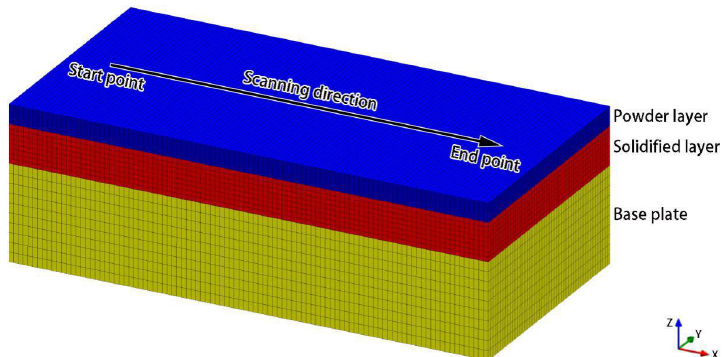
Figure 4. Adopted geometry and mesh models.